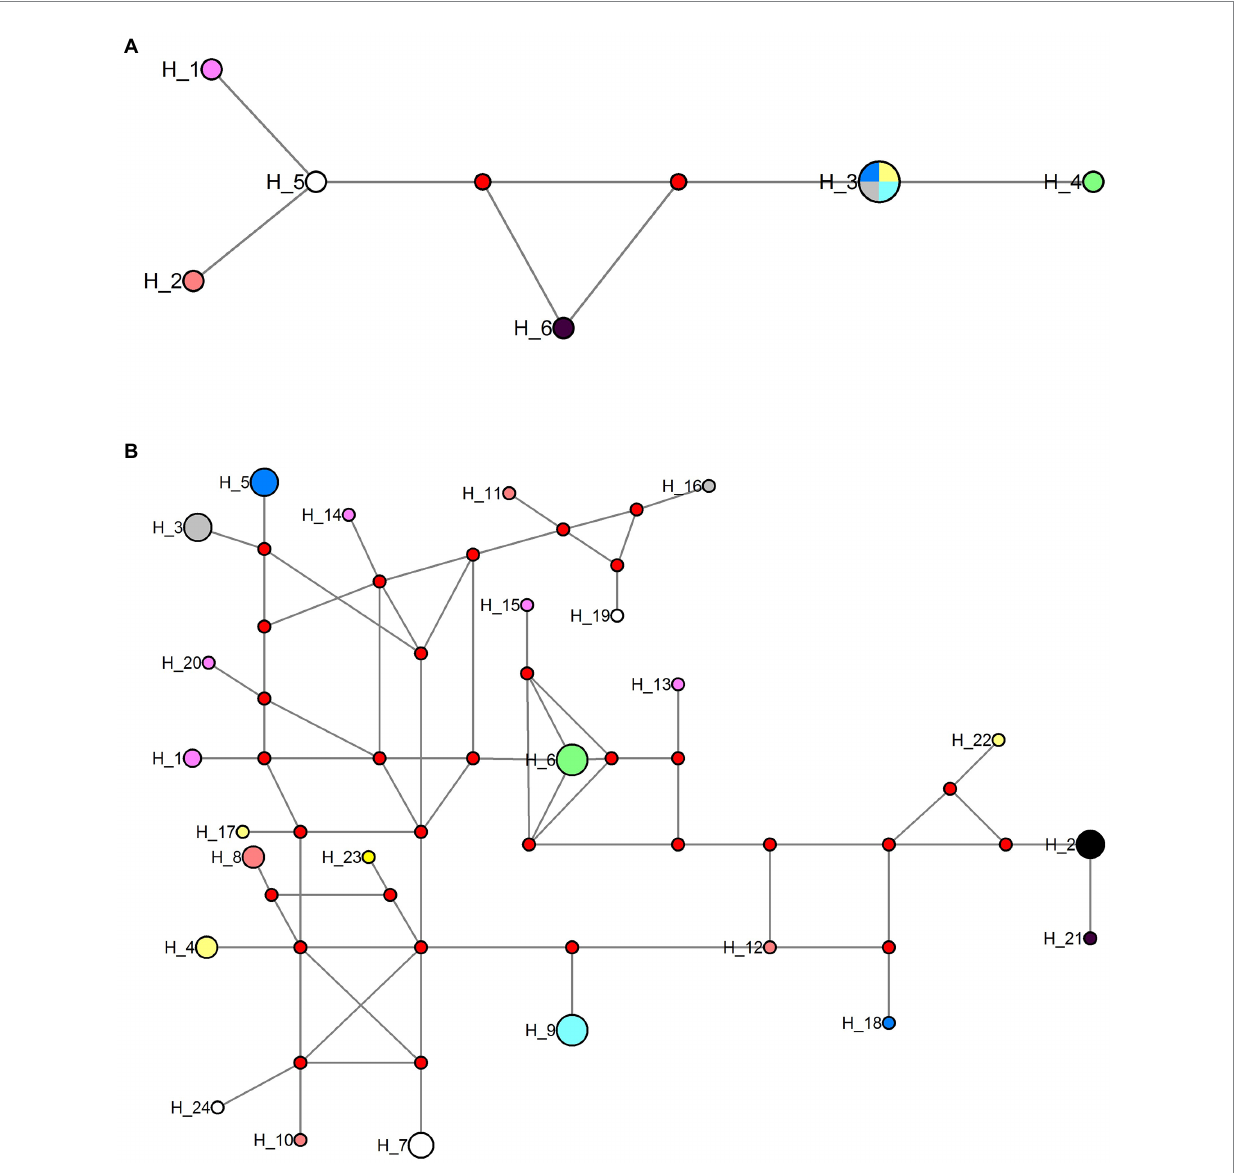
FIGURE 7 Haplotype network of Pseudokabatana alburnus from different hosts and geographical origin using the ITS and Rpb1 sequences data set. (A) Haplotype network of P. alburnus isolates using ITS sequence data set. (B) Haplotype network of P. alburnus isolates using Rpb1 sequences data set. Haplotypes are depicted by circles, the width being proportional to their frequencies. Red circle indicates a single connection step between the Rpb1 sequences. Color codes are as follows; light red: haplotypes obtained from Squaliobarbus curriculus (Lake Poyang); pink: haplotypes obtained from Hemiculter leucisculus (Lake Luoma); black: haplotypes obtained from Pseudolaubuca engraulis (Lake Luoma); gray: haplotypes obtained from Cultrichthys erythropterus (Lake Luoma); yellow: haplotypes obtained from Toxabramis swinhonis (Lake Luoma); dark blue: haplotypes obtained from Culter alburnus (Lake Poyang); green: haplotypes obtained from H. leucisculus (Lake Weishan); white: haplotypes obtained from C. erythropterus (Lake Weishan); wathet: haplotypes obtained from Elopichthys bambusa (Lake